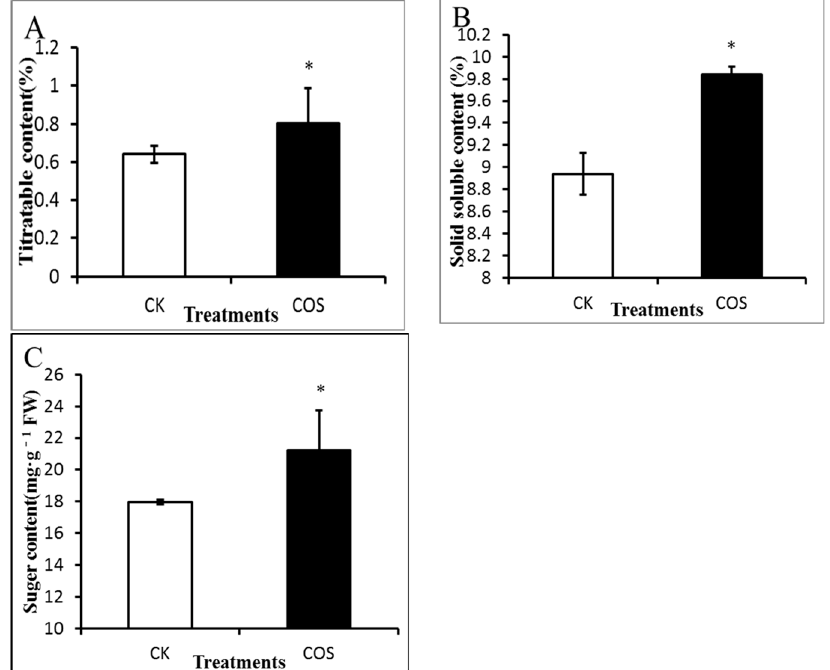
Figure 2. Effect of COS pre-harvest treatment on quality of strawberry fruit. ( A ) Titratable acidity; ( B ) Solid soluble content; ( C ) Sugar content. Data represent the means ± SD. The symbol star (*) means significantly different according to T test at p ≤ 0.05 level. CK: Spraying water pre-harvest; COS: Spraying COS pre-harvest.